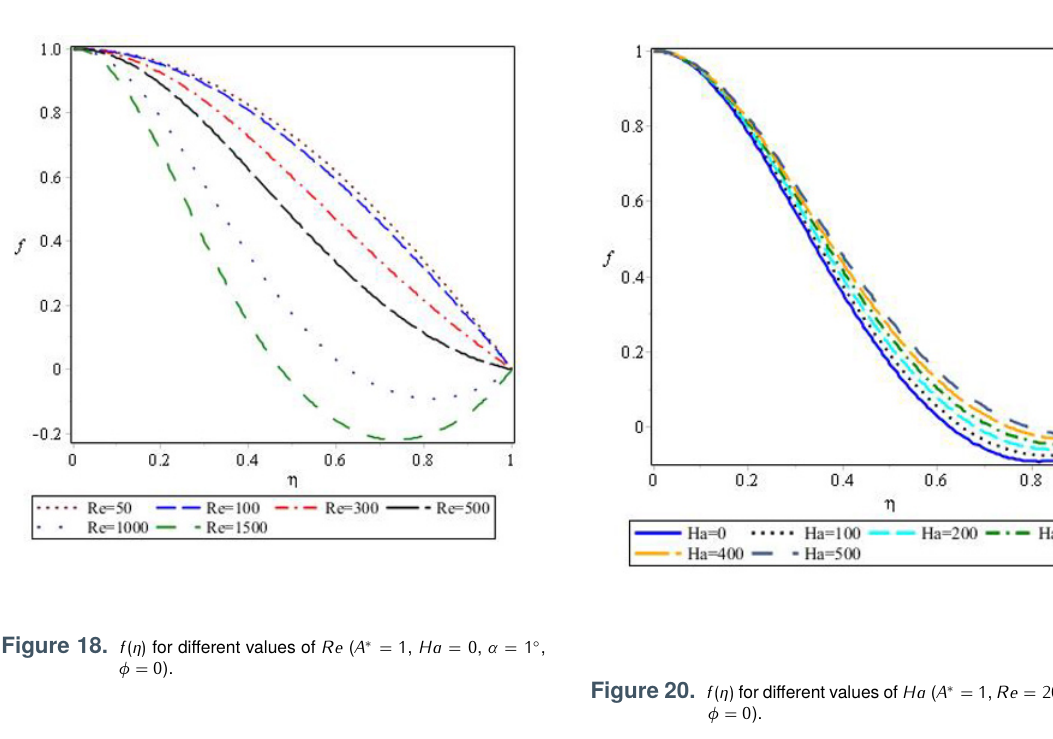
Figure 20. f ( η ) for different values of Ha ( A ∗ = 1 , Re = 200 , α = 5 ◦ , φ = 0 ).